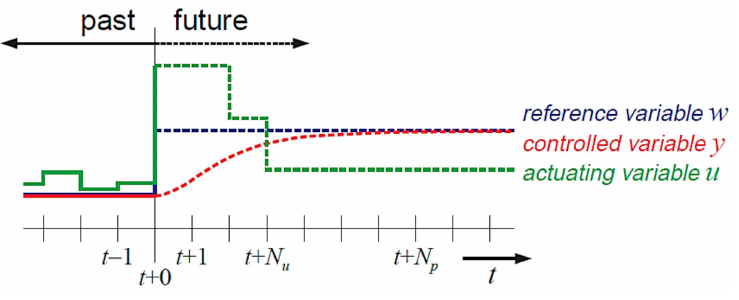
Figure 13. MPC operation